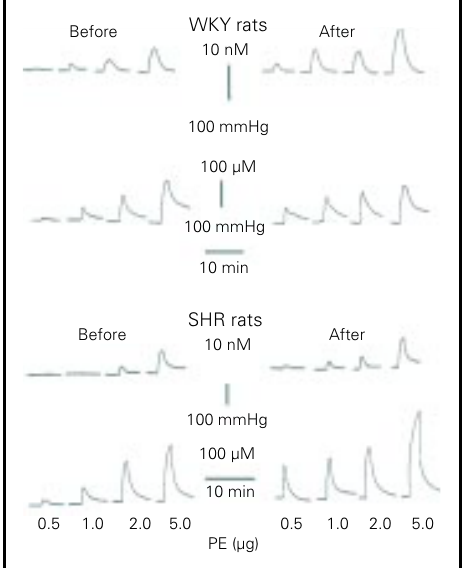
Figure 1 - Typical tracings dem- onstrating the effects of 100 (cid:181)M and 10 nM ouabain treatment on the phenylephrine (PE)-in- duced vasopressor changes in rat tail vascular beds from nor- motensive Wistar Kyoto (WKY) and hypertensive (SHR) rats. Observe the sensitization to the PE pressor response that occurs after ouabain